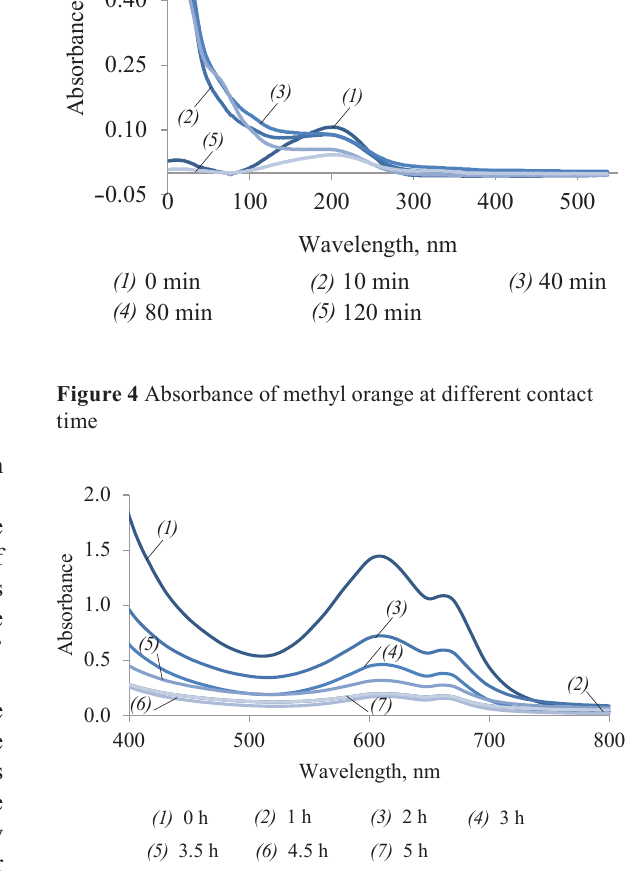
Figure 5 Absorbance of textile raw water at different time of contact